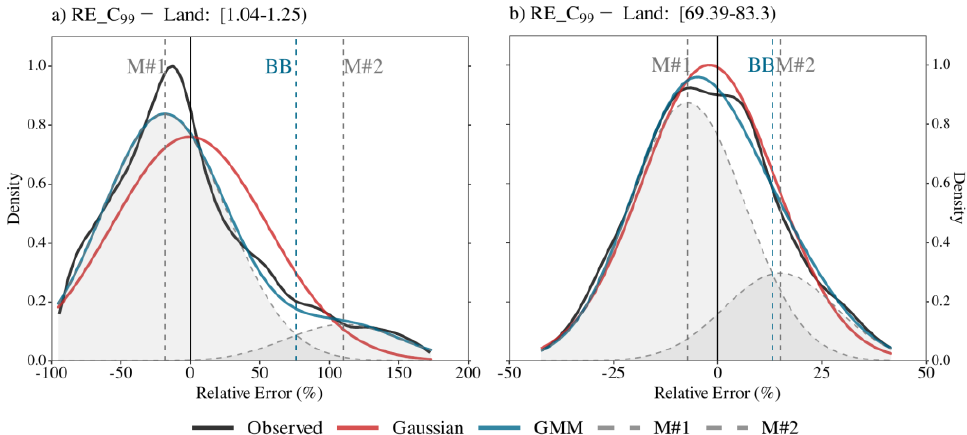
Figure 4. An example of over-land global uncertainty distributions ( x -axis, in %) during the JJA of 2014 for the daily precipitation bins ( a ) 1.04 – 1.25 mm day −1 and ( b ) 69.39 – 83.3 mm day −1 , resulted from the comparison between the C 99 and the C REF experiments. The GMM fit with M = 2 (blue line) is contrasted with a simple Gaussian fit (red line) to represent the observed distribution (black line). Note that GMM “modes” (M#1 and M#2) are in grey filled area dashed curves. The perpendicular dashed lines indicate the Bayesian boundaries between the two GMM modes (in blue) and its correspondent mean values (in grey).